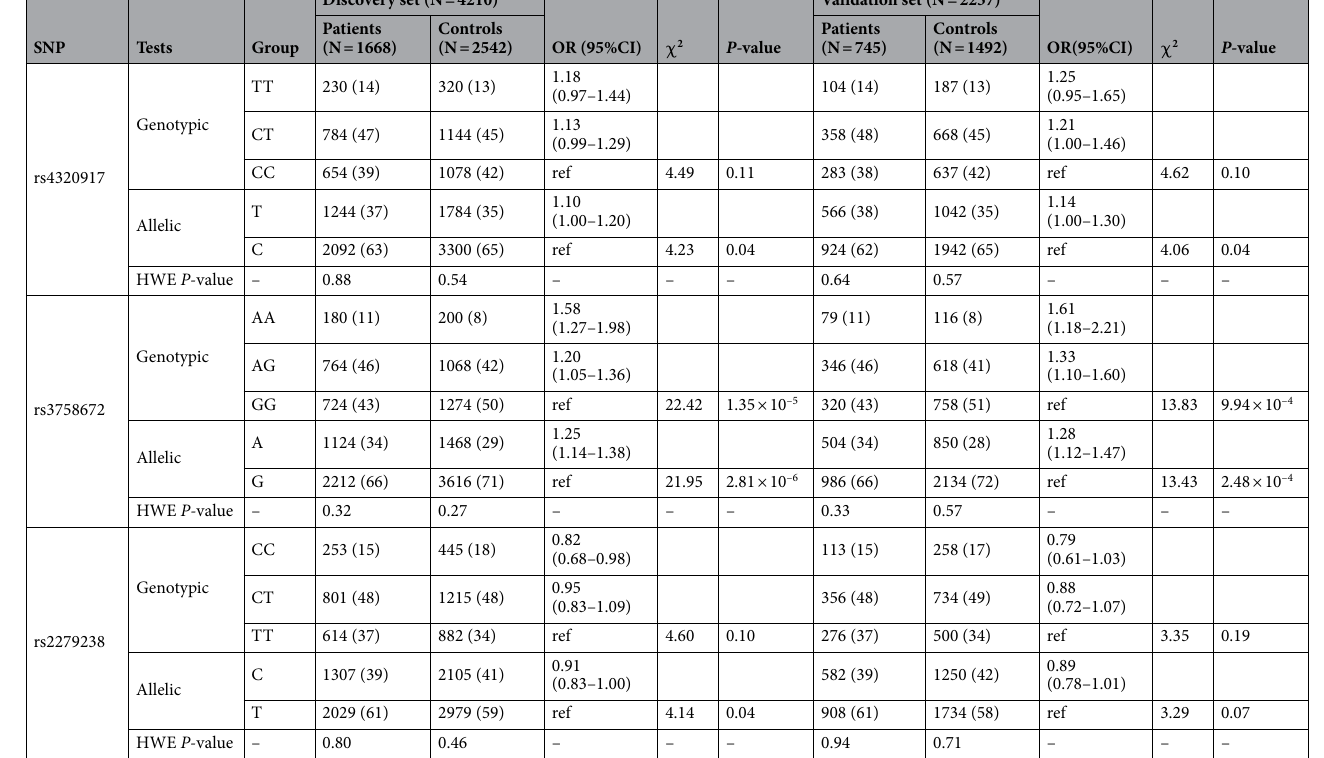
Table 2. Results of genetic association analyses for SNPs genotyped in both discovery and validation sets. HWE: P value of the Hardy–Weinberg equilibrium. The threshold of P value is